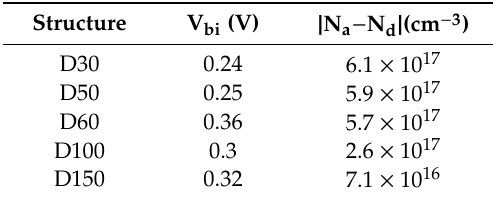
Table 2. Mott–Schottky analysis results of Si / GaN NW / P3HT:PC 71 BM heterostructures for nanowire